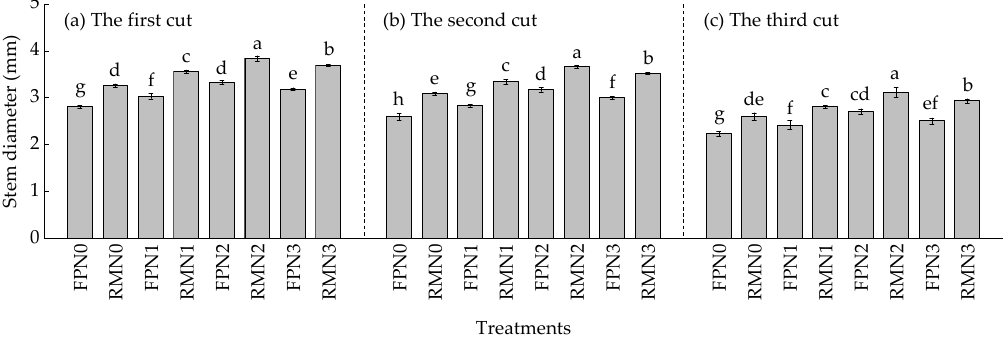
Figure 4. Impact of planting pattern and nitrogen level on the stem diameter of alfalfa. FP and RM refer to conventional flat planting and ridge culture with film mulching, respectively. N0, N1, N2, and N3 refer to nitrogen application rates of 0 kg · ha − 1 , 80 kg · ha − 1 , 160 kg · ha − 1 , and 240 kg · ha − 1 . Different lowercase letters indicate significant difference among treatments ( p <